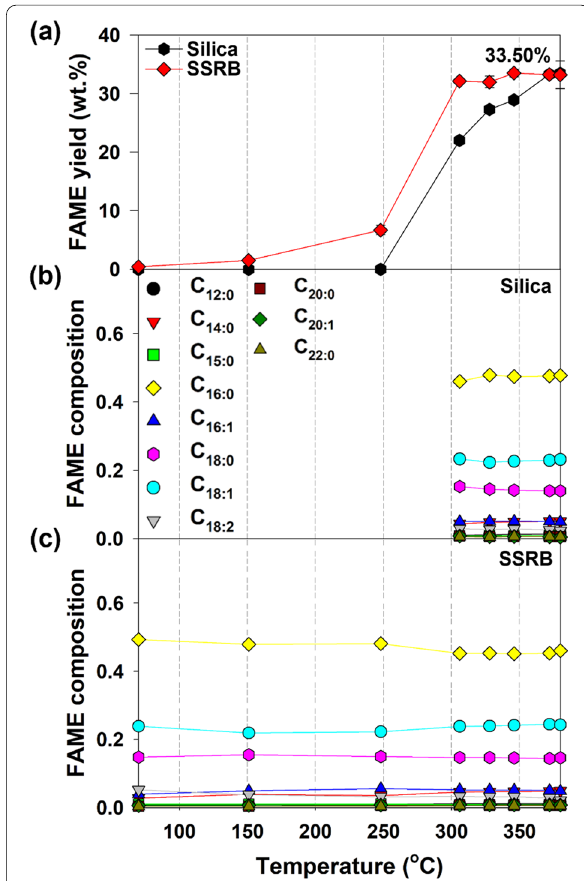
Fig. 7 a FAME yields per SS extract and ( b , c ) FAME compositions obtained from thermally induced transesterification of SSE in the presence of silica and SSRB